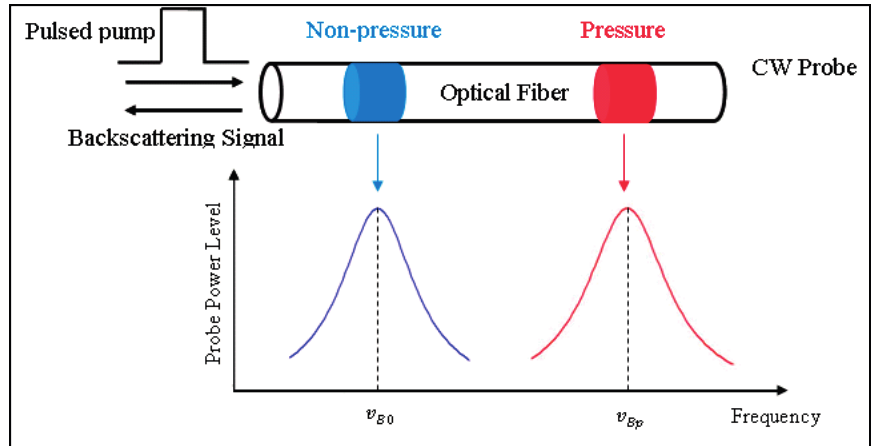
Figure 2. Measurement principle in BOTDA